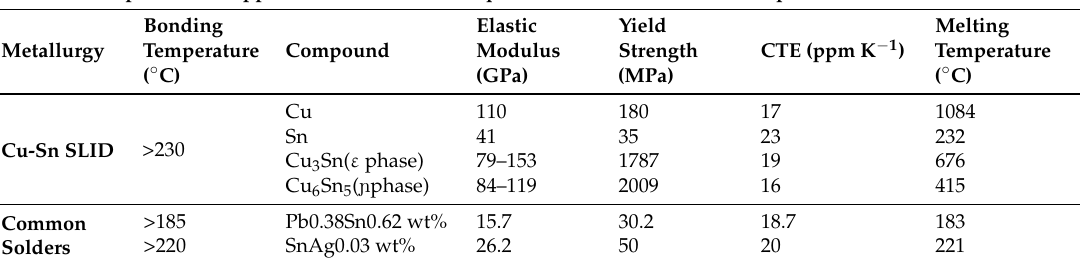
Table 5. Materials properties of copper (Cu)–solid-liquid interdiffusion (SLID) compounds compared to solders commonly used in the integrated circuit (IC) industry